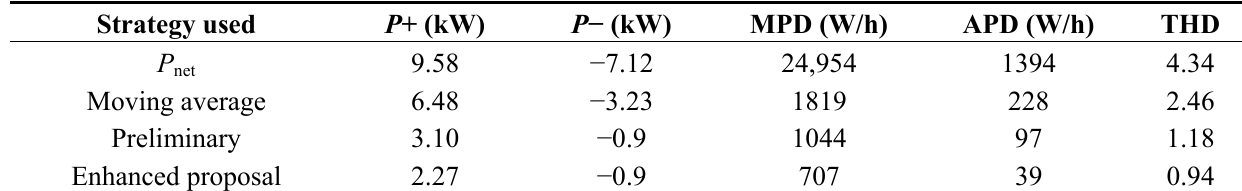
Table 1. Quality criteria calculated for every energy management strategy. MPD: maximum power derivative; APD: Average power derivative; THD: Variability.